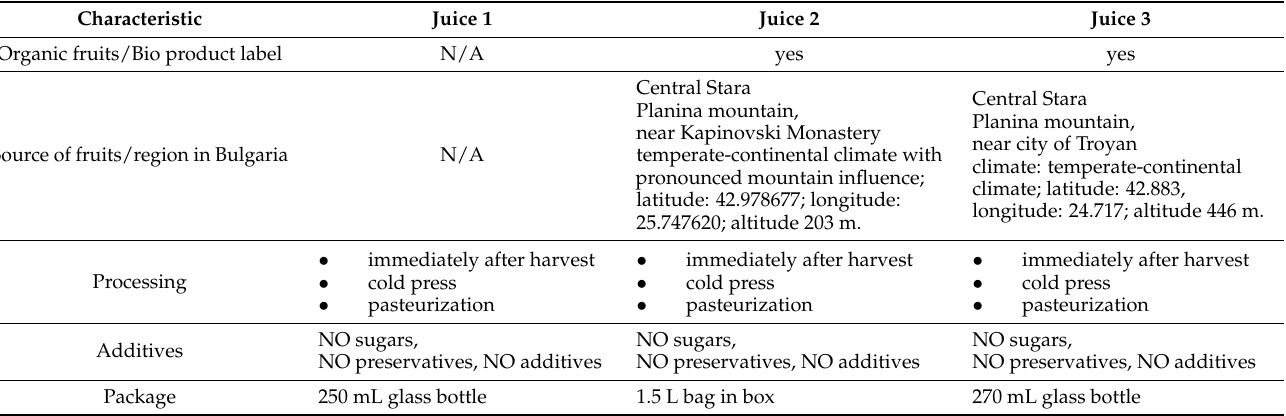
Table 3. Characteristics of analyzed samples from 3 juices made by Aronia melanocarpa L. fresh fruits. Characteristic Juice 1 Juice 2 Juice 3 Organic fruits/Bio product